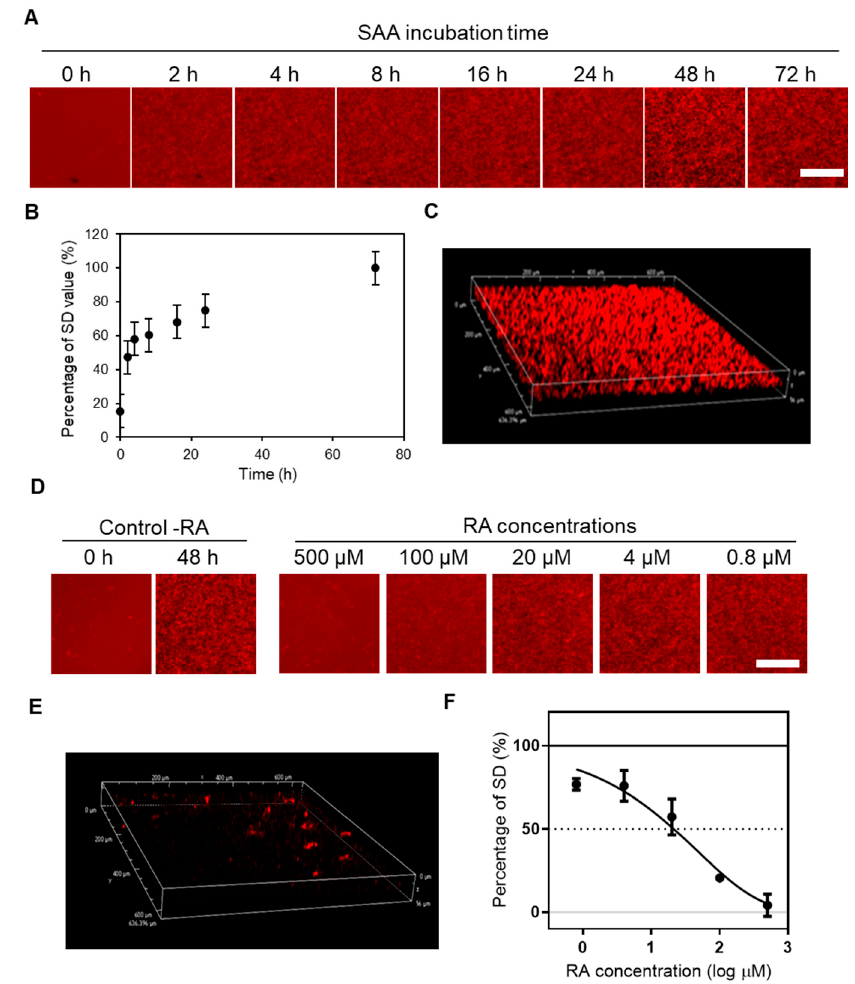
Figure 1. Real-time imaging of mouse serum amyloid A (mSAA) aggregation using quantum-dots (QDs) and evaluation of inhibitory activity of rosmarinic acid (RA) using the microliter-scale high-throughput screening system (MSHTS) system. ( A ) Real-time 2D imaging of mSAA aggregations were captured by conventional fluorescence microscopy using a 4 × objective for 0, 2, 4, 8, 16, 24, 48, and 72 h. The images show the central area in a well observed by fluorescence microscopy at each incubation time. ( B ) Standard deviation (SD) value of each image by time-dependent mSAA protein aggregation. ( C ) 3D imaging of mSAA aggregation was captured by confocal microscopy. ( D ) 2D fluorescence microscopic images of mSAA aggregates in the absence (control) or presence of various concentrations of RA after 48 h incubation. ( E ) 3D visualization of mSAA aggregation in the presence of 125 µ M RA. ( F ) Estimation of EC 50 values from an inhibition curve ( n = 3 separate experiments). Scale bars in fluorescent micrographs indicate 100 µ m. Each plot represents mean ± SEM. The percentage of SD was defined as SD values before and after the incubation of samples (0% and 100%, respectively).